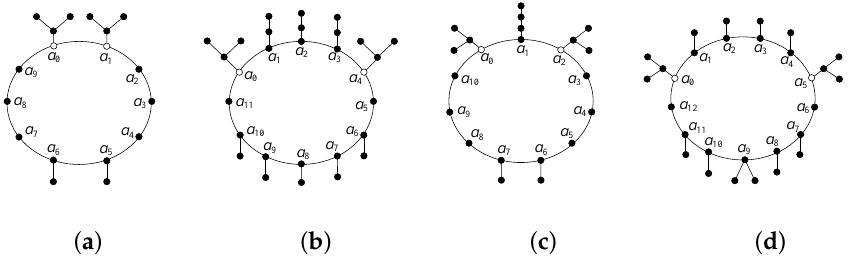
Figure 2. ( a ) Edge-even-(10,1); ( b ) edge-even-(12,4); ( c ) edge-odd-(11,2); ( d )